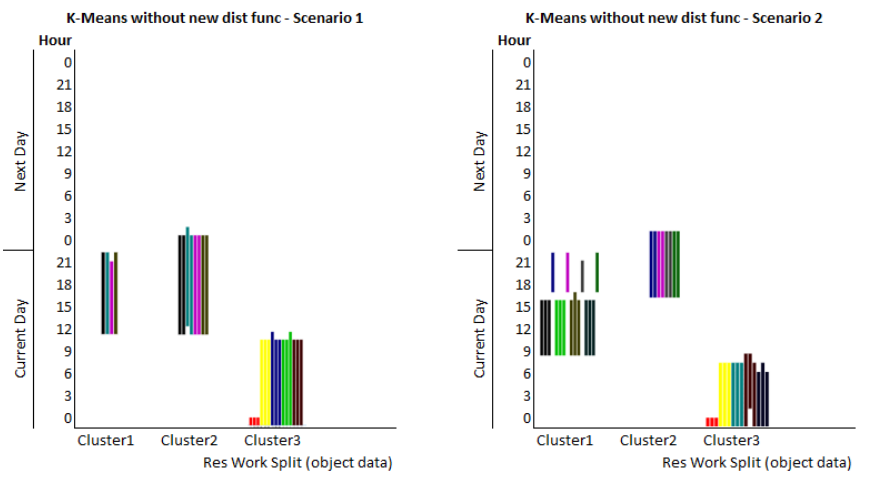
Figure 10. The comparison of clustering k -means without the new distance function.